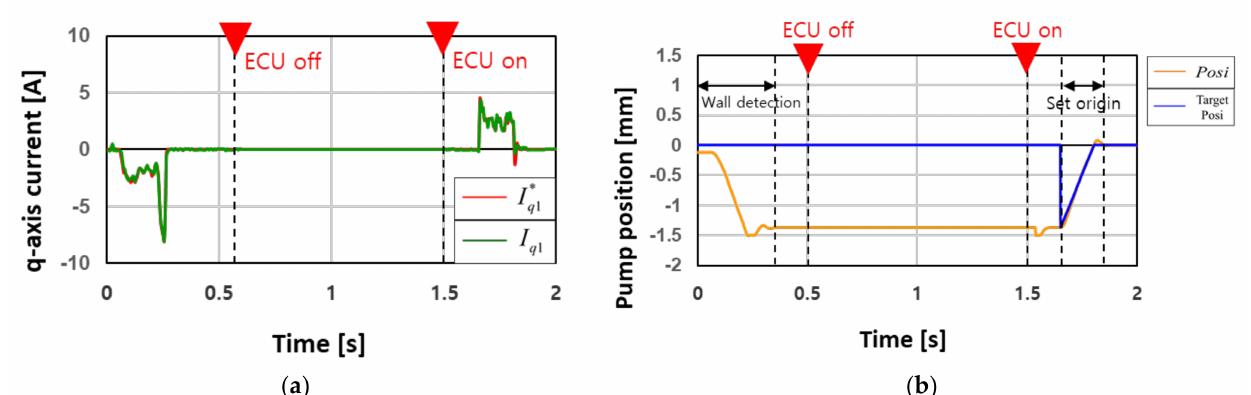
Figure 11. Measurement results regarding wall detection process with the ignition off and wall detection skip and origin set. process through motor initial operation with the ECU on: ( a ) q − axis ) and measured q − axis current value ( I ) ; ( b ) target pump piston current command value ( I ∗ q 1 q 1 position and calculated pump piston position.